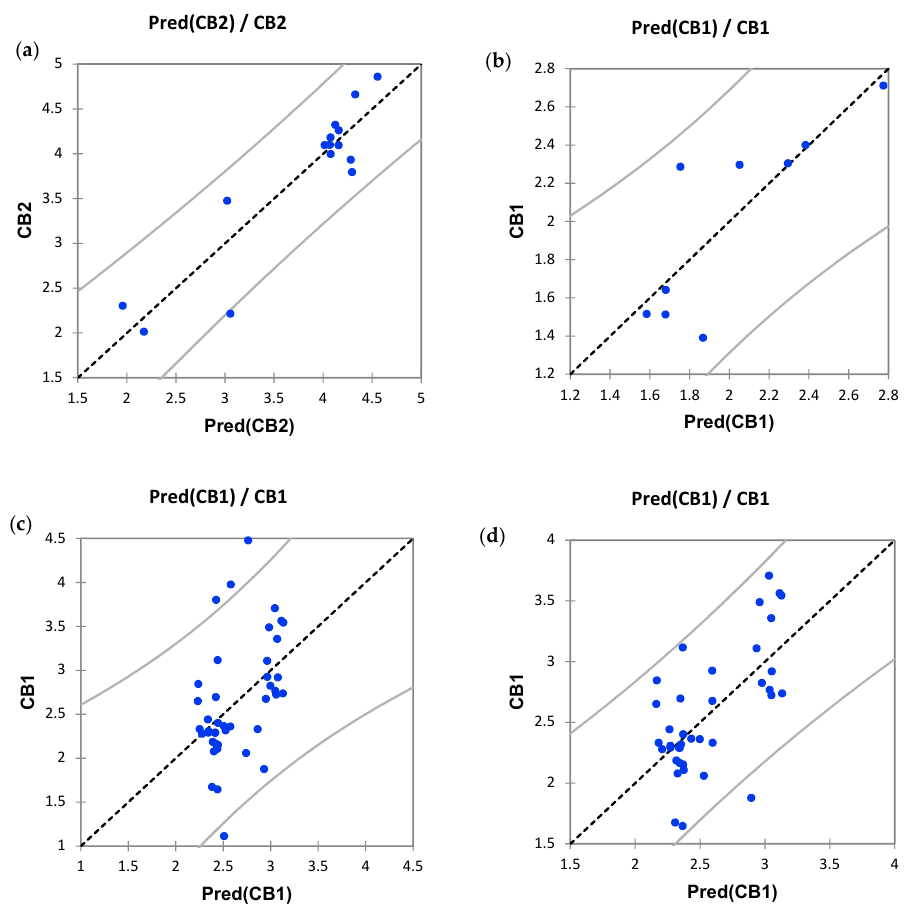
Figure 2. Distribution of calculated versus experimental receptor potencies for the models described by Equations (1)–(3) (above) ( a – c , respectively) and Equation (4) (vide infra, d ).